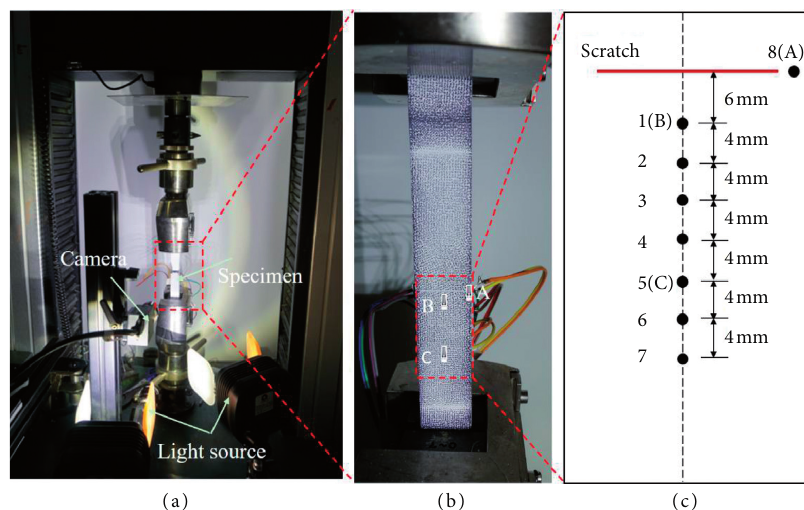
Figure 2: (a) Experimental setup for tensile tests. (b) Photo of the scratched sample. Points A, B, and C denote the locations of the strain gauges on the back face of the sample. (c) Points 1–8 denote the locations of strain evaluated using